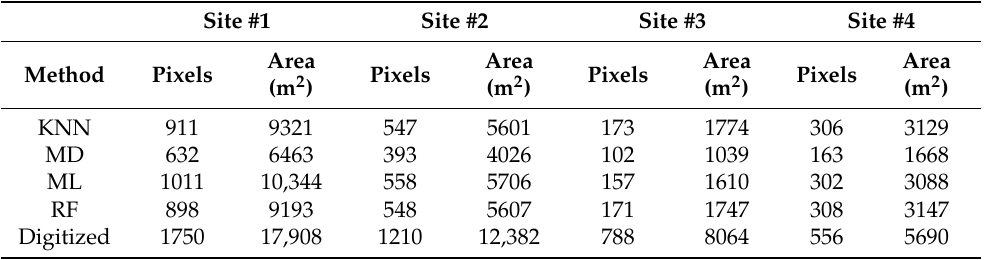
Table 2. Aerial extent (m 2 ) of actual gullies (digitized) and classified gullies based on different